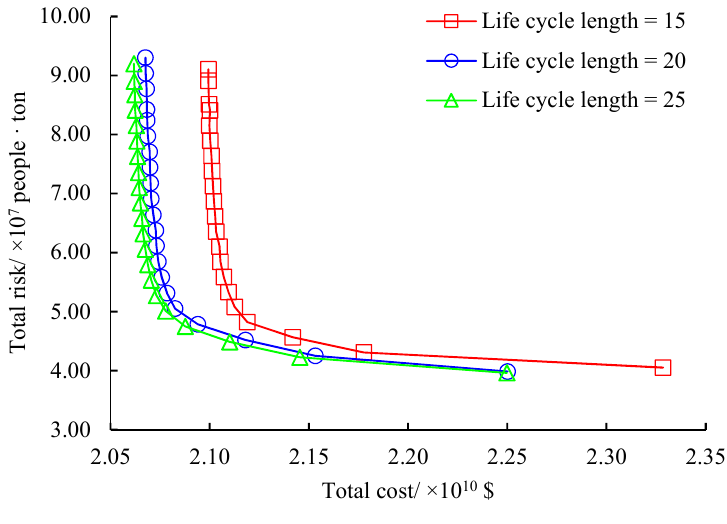
Figure 12. Effects of life cycle